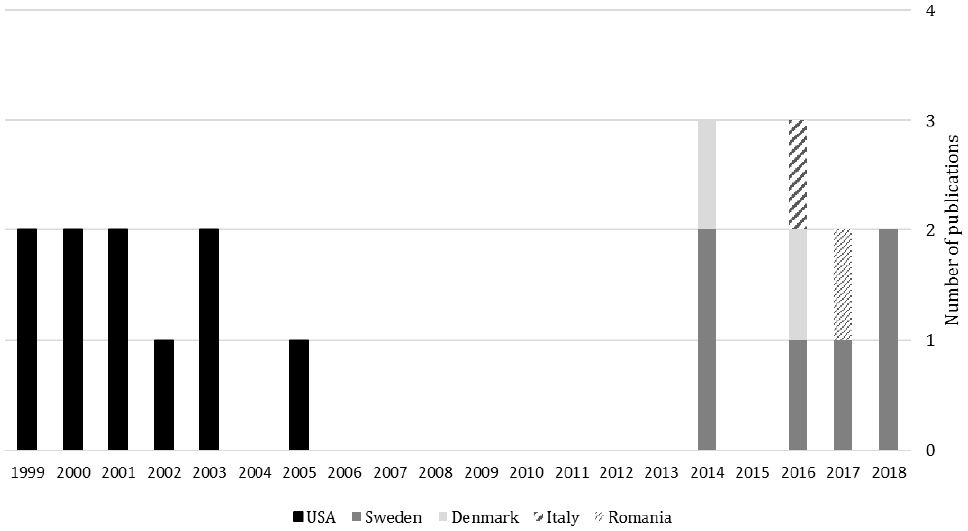
Figure 3. The number of published articles per year and by geographical origin in the area of non-energy benefits in industry.